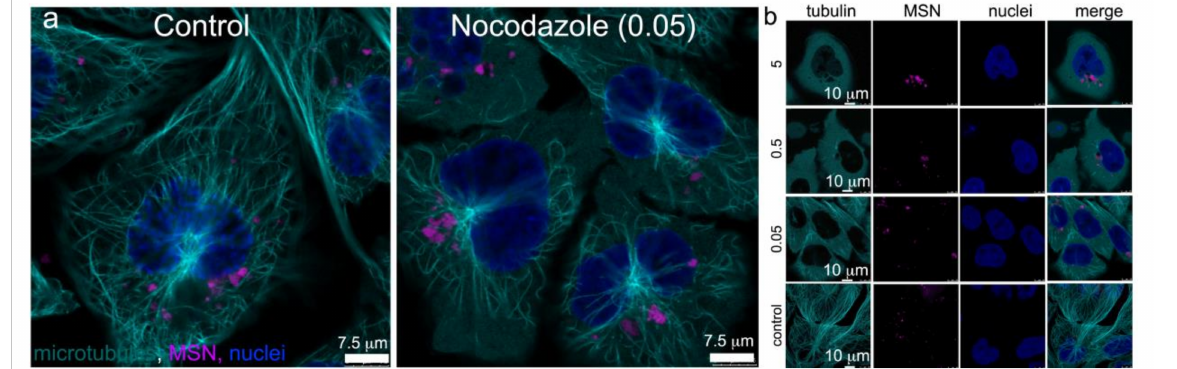
Figure 3. Disruption of MSN-endolysosome trafficking through inhibition of tubulin polymerization. ( a , b ) Confocal fluorescent micrographs of HeLa cells incubated with DyLight 633 MSN (magenta) in the absence (control) or presence of nocodazole. Cells were post fixation-labeled with AF488 anti- α -tubulin antibody (cyan; microtubules) and DAPI (blue; nuclei). ( a ) Comparison of control and nocodazole-treated (0.05 µ g/mL) HeLa cells. ( b ) HeLa cells incubated with 0–5 µ g/mL nocodazole.